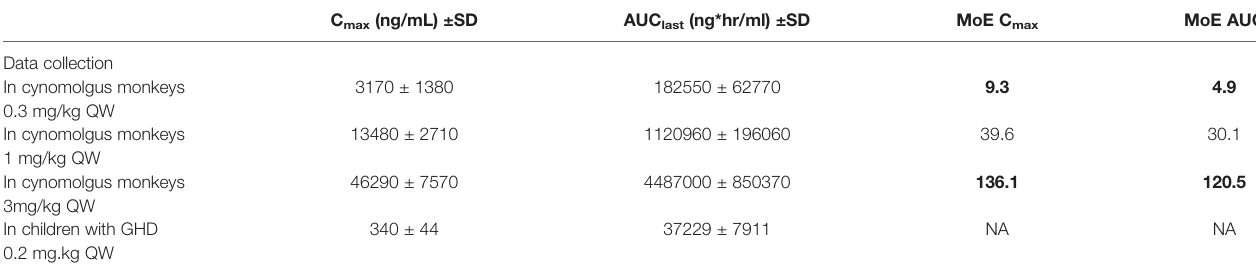
TABLE 5 | Safety Margins for the proposed clinical